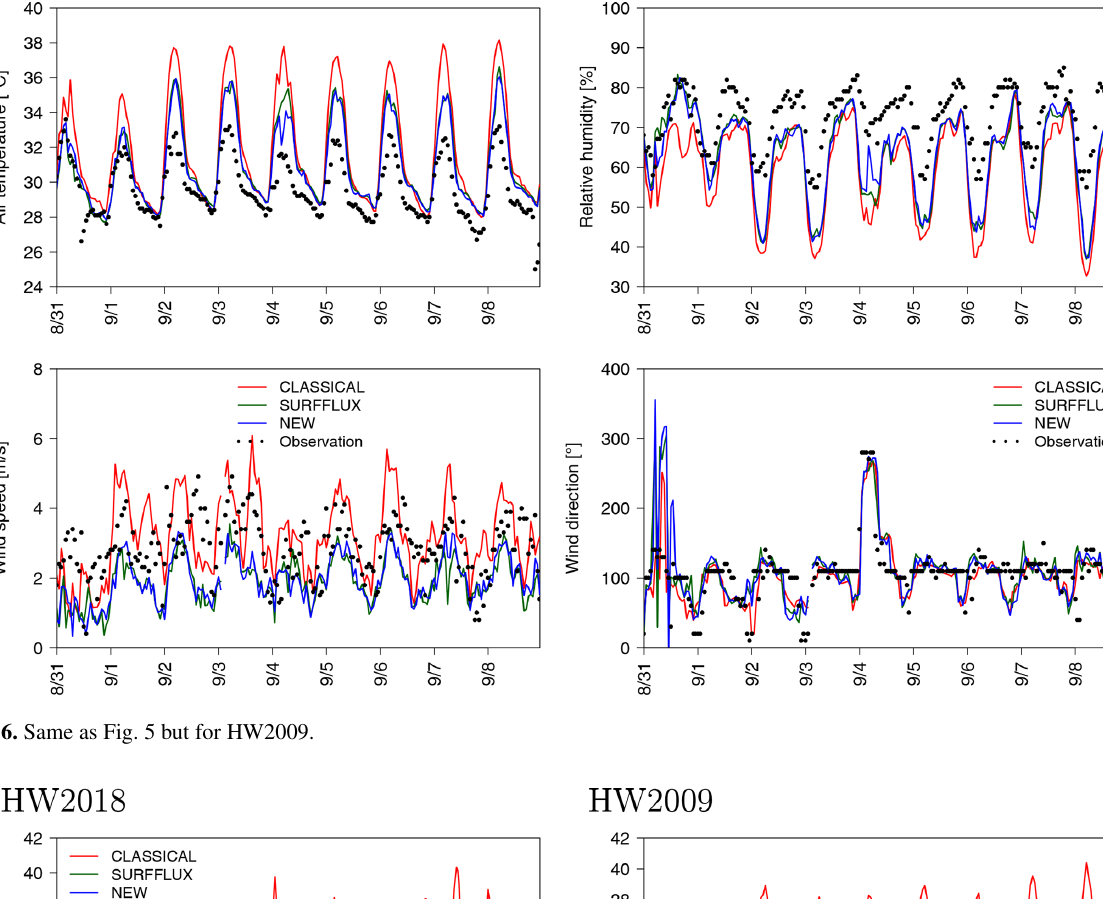
Figure 6. Same as Fig. 5 but for HW2009.